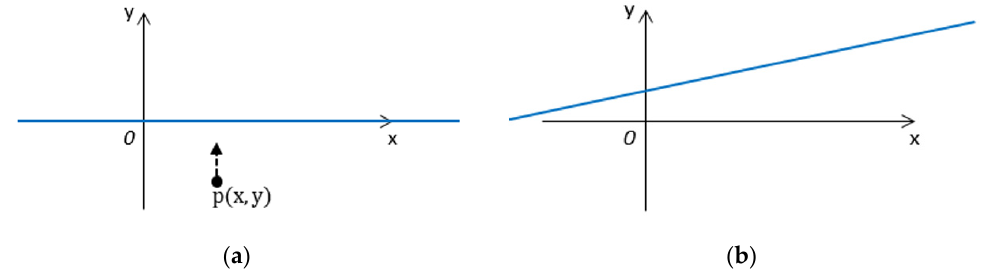
Figure 6. Path approach: ( a ) Situation where φ path is zero; ( b ) Situation where φ path is not zero.